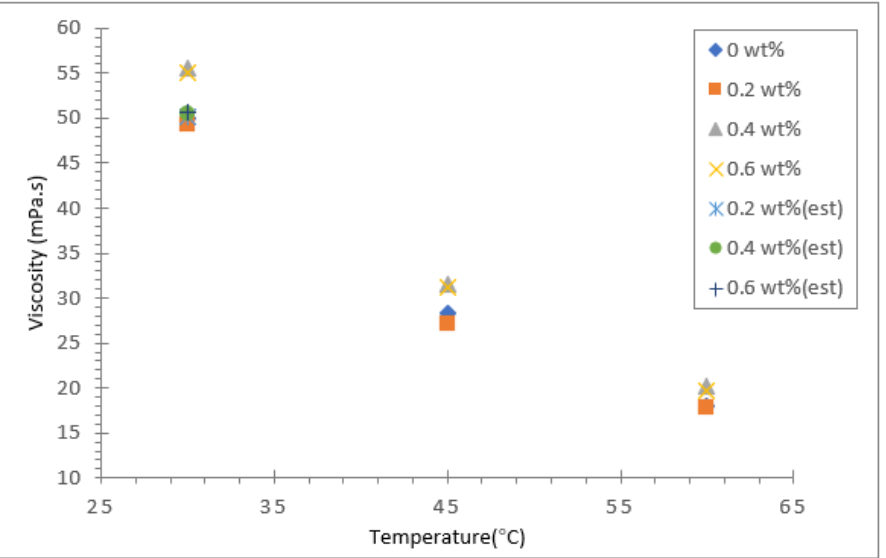
Figure 10. Dynamic viscosity of soybean/Al 2 O 3 -TiO 2 hybrid nanofluid.